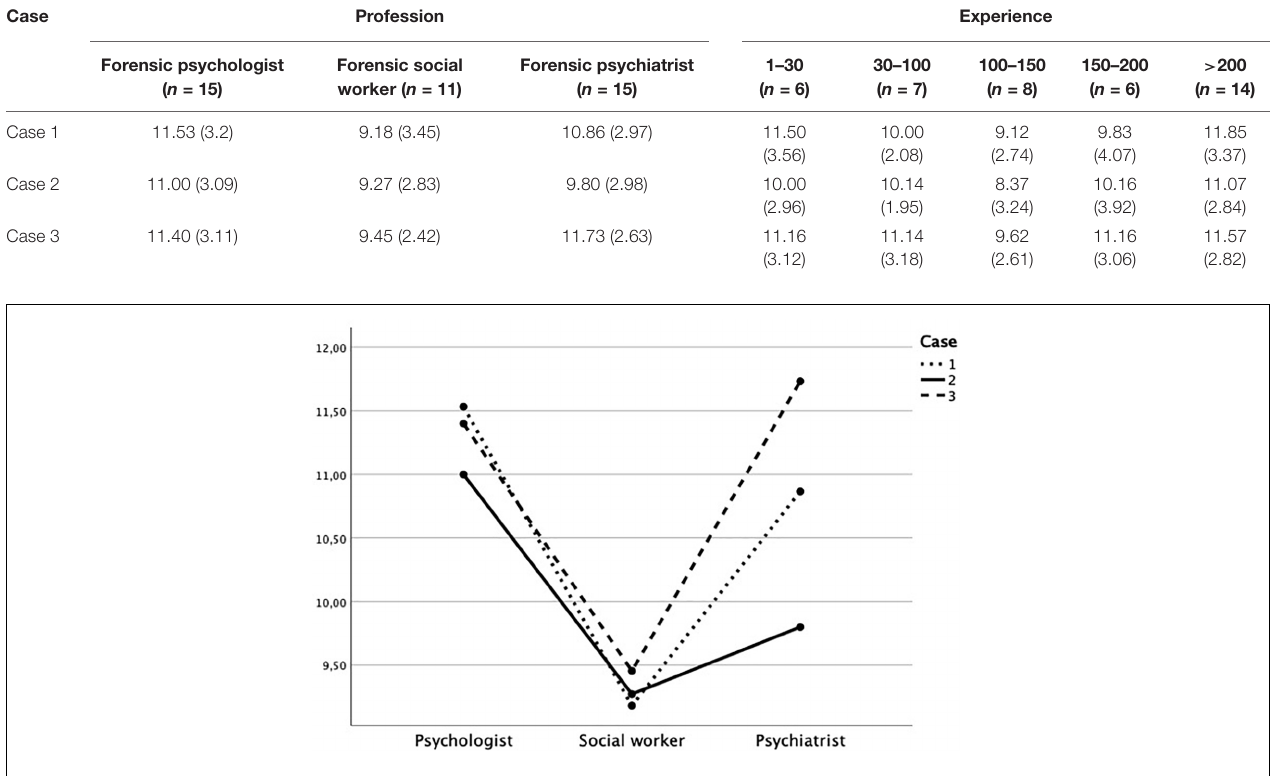
p = 0.007, η 2 = 0.23]. There was no significant interaction between type of case and profession [Wilks’ Lambda =